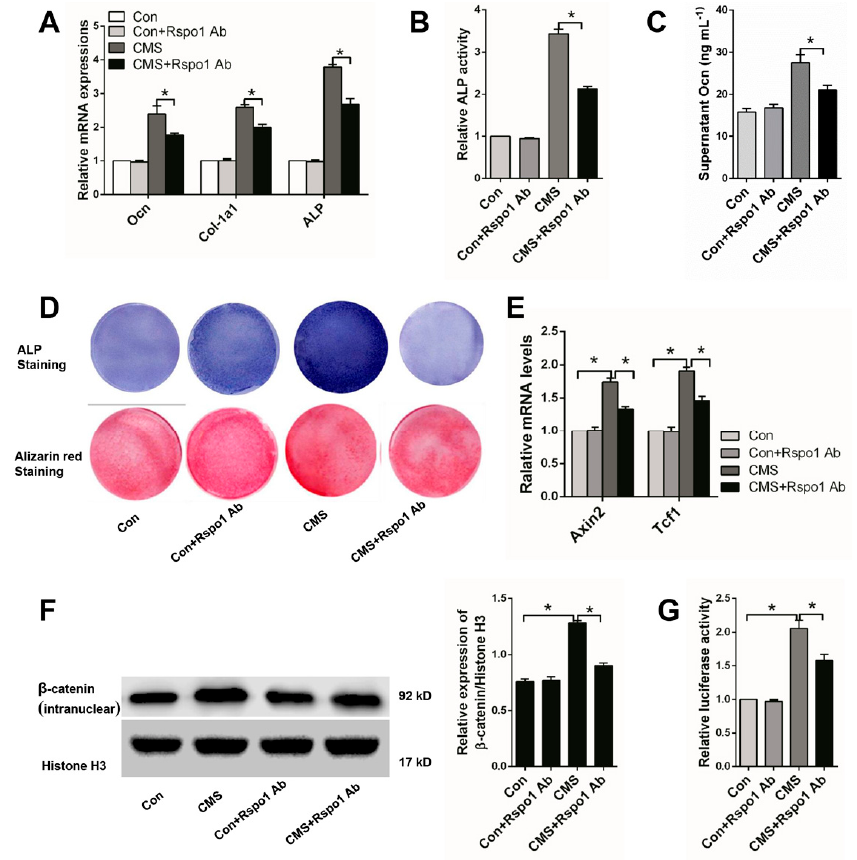
Figure 4. Rspo1 neutralizing antibody (Rspo1 Ab) (1 µ g/mL) abolished the enhanced osteogenic differentiation and Wnt/ β -catenin activity by CMS (5% elongation) in BMSCs. ( A ) qRT-PCR analysis of osteogenic differentiation markers Ocn , Col-1a1 and ALP (Day 3); ( B ) relative ALP activities (Day 7); ( C ) ELISA measurement for supernatant Ocn (Day 3); ( D ) Representative images of ALP staining (Day 7) and Alizarin red staining (Day 14); ( E ) qRT-PCR analysis of the Wnt target genes Axin2 and Tcf1; ( F ) Western blot analysis of the intranuclear level of β -catenin and ( G ) Topflash